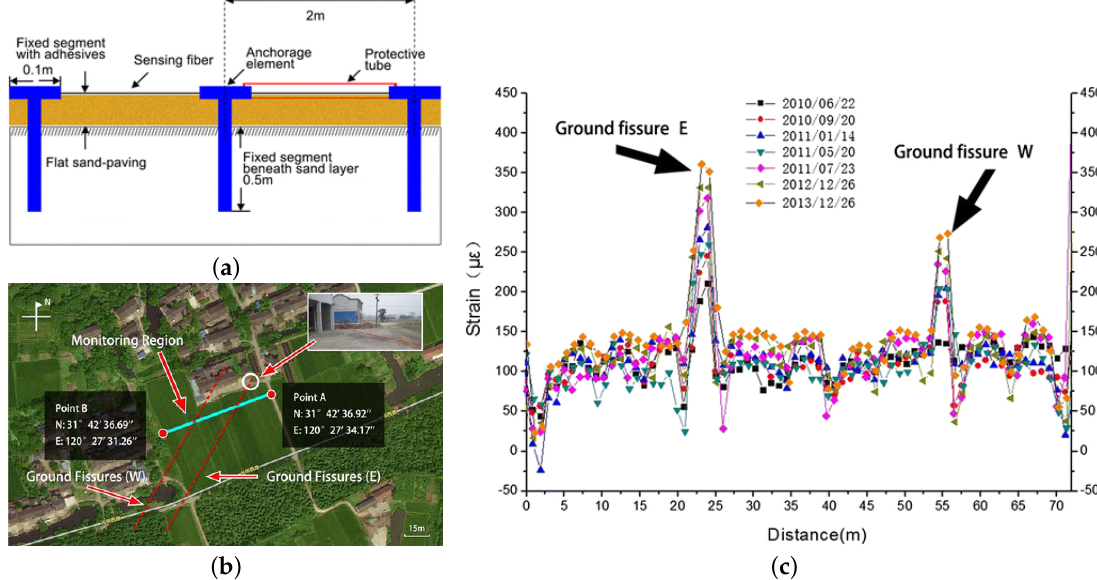
Figure 22. ( a ) Deployment setup of a cable for ground fissure monitoring. ( b ) Monitoring site in Yangshuli, Wuxi, China. ( c ) Strain distribution along the cable: the two peaks locate the main ground fissure E and W, respectively. Reproduced with permission from